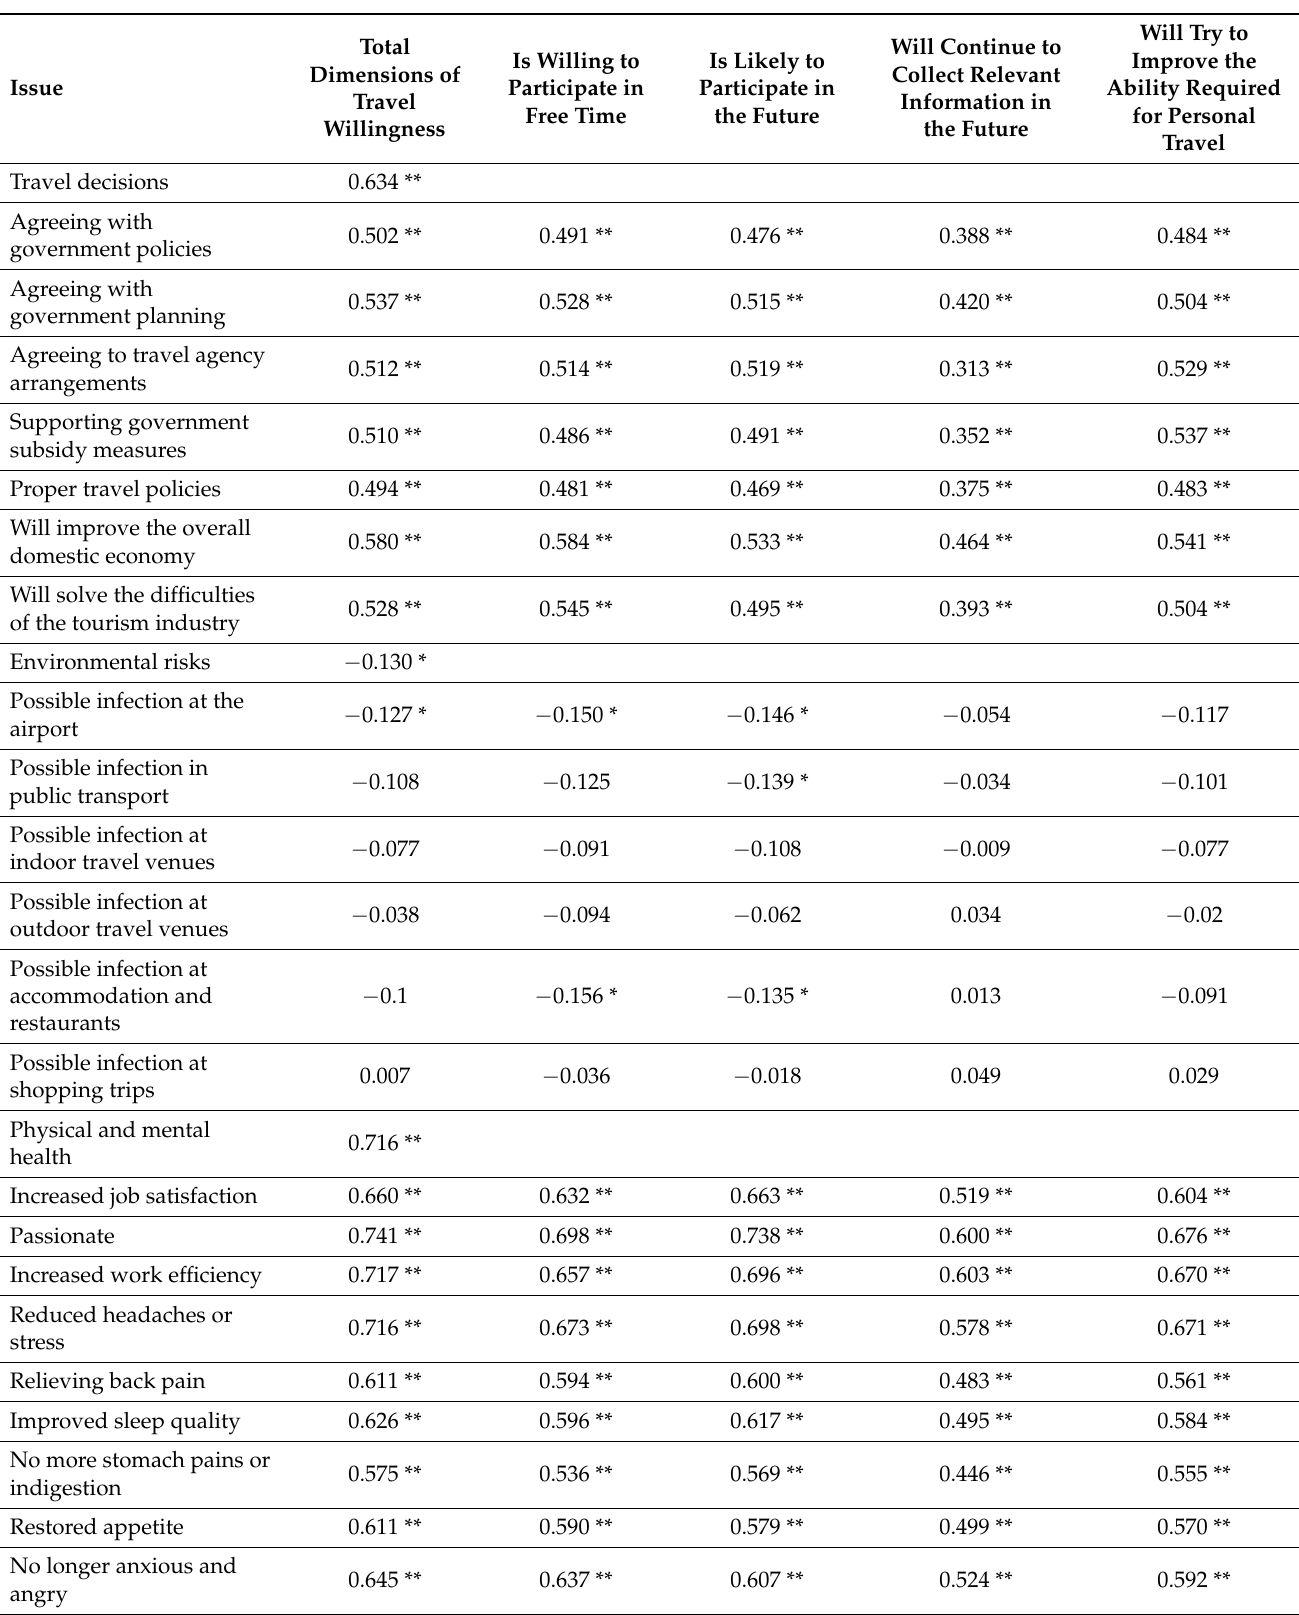
Table 5. Analysis of the correlation between travel decisions, risk perception, health beliefs, physical and mental health, and travel